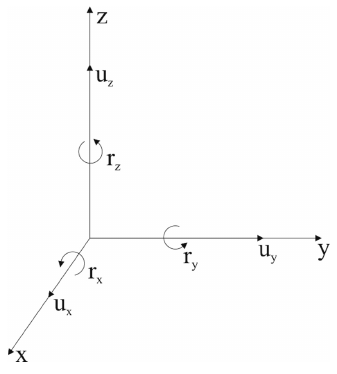
Figure 1. Schematic diagram of the rotational motion. In order to completely describe the ground motion, six degrees of freedom in a three dimensional world are required, as shown in Table 1 [43]. In the two-dimensional case, it becomes three components—the radial (u x ), vertical (u z ), and yaw (r y ) components. We analyze the wave-field characteristics of three components under the assumption of two- dimensional linear small deformation and use the surface-wave dispersion curves ex- tracted from different components to predict shear-wave phase velocity. Table 1. The ground motion. Axis